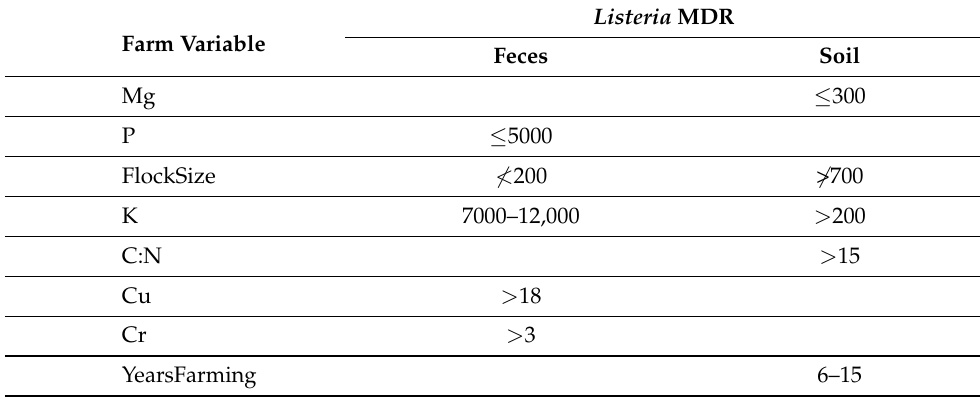
Table 6. Pre-harvest feature value recommendations for reducing for Listeria MDR